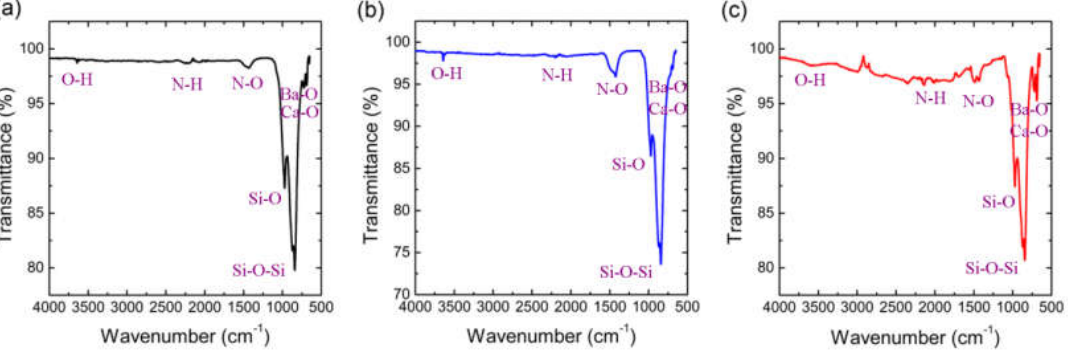
Figure 2. FTIR spectra of Ba 1.3 Ca 0.7 SiO 4 samples burned at 550 °C: ( a ) metal nitrate:urea = 1:0.75, ( b ) ( b ) metal nitrate:urea = 1:1.15, and ( c ) metal nitrate:urea = metal nitrate:urea = 1:1.15, and ( c ) metal nitrate:urea = 1:2.15.